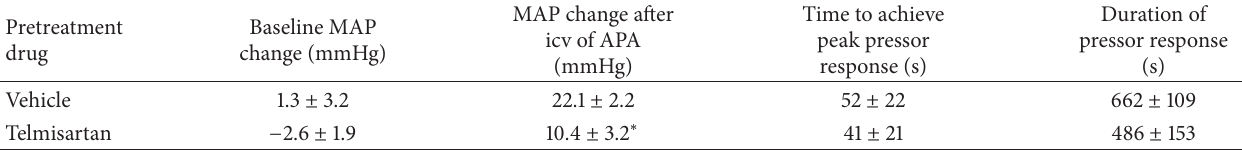
Duration of pressor response